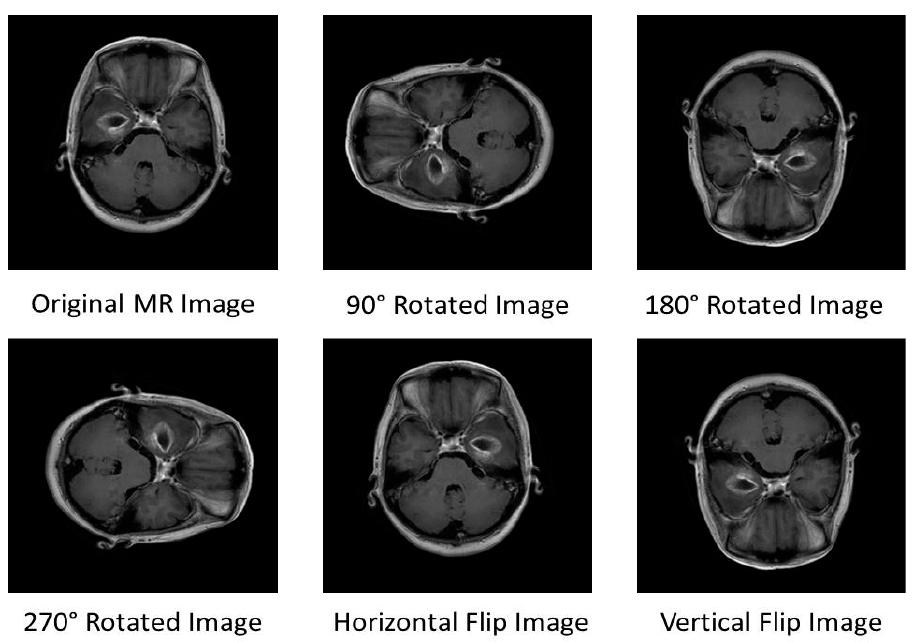
Figure 2. Sample brain tumor dataset from Figshare ( a ) Glioma ( b ) meningioma ( c ) pituitary.